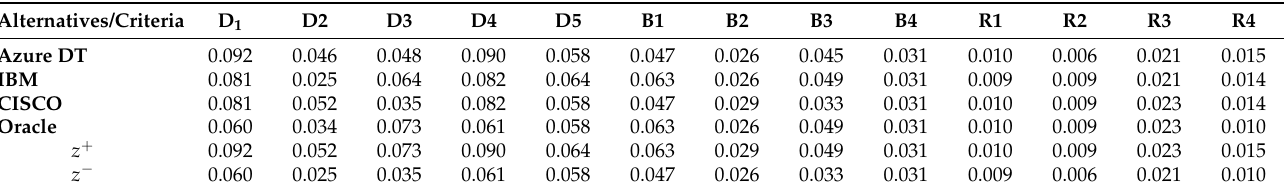
Table 8. The normalization of alternatives with respect to criteria.